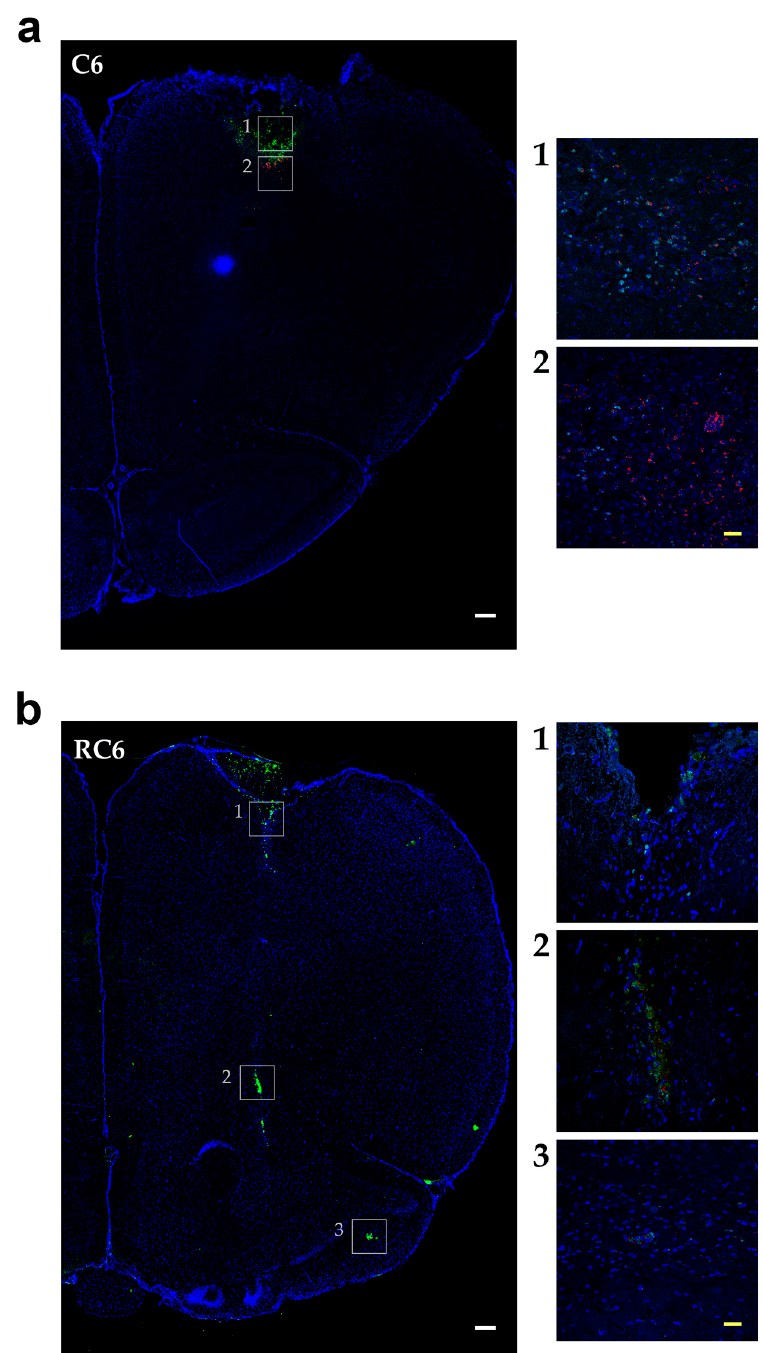
Figure 5. Invasion of C6 and RC6 cells 25 days after inoculation. ( a ) Representative images of coronal sections of Wistar rat brain from C6; and ( b ) RC6 group. Inoculated cells were stained with fluorescent dye CFSE ( green ) and proliferation marker anti-Ki67 antibody ( red ). Nuclei were counterstained with Hoechst 33342 ( blue ). Scale bar = 200 μ m ( white ), scale bar = 25 μ m ( yellow ).